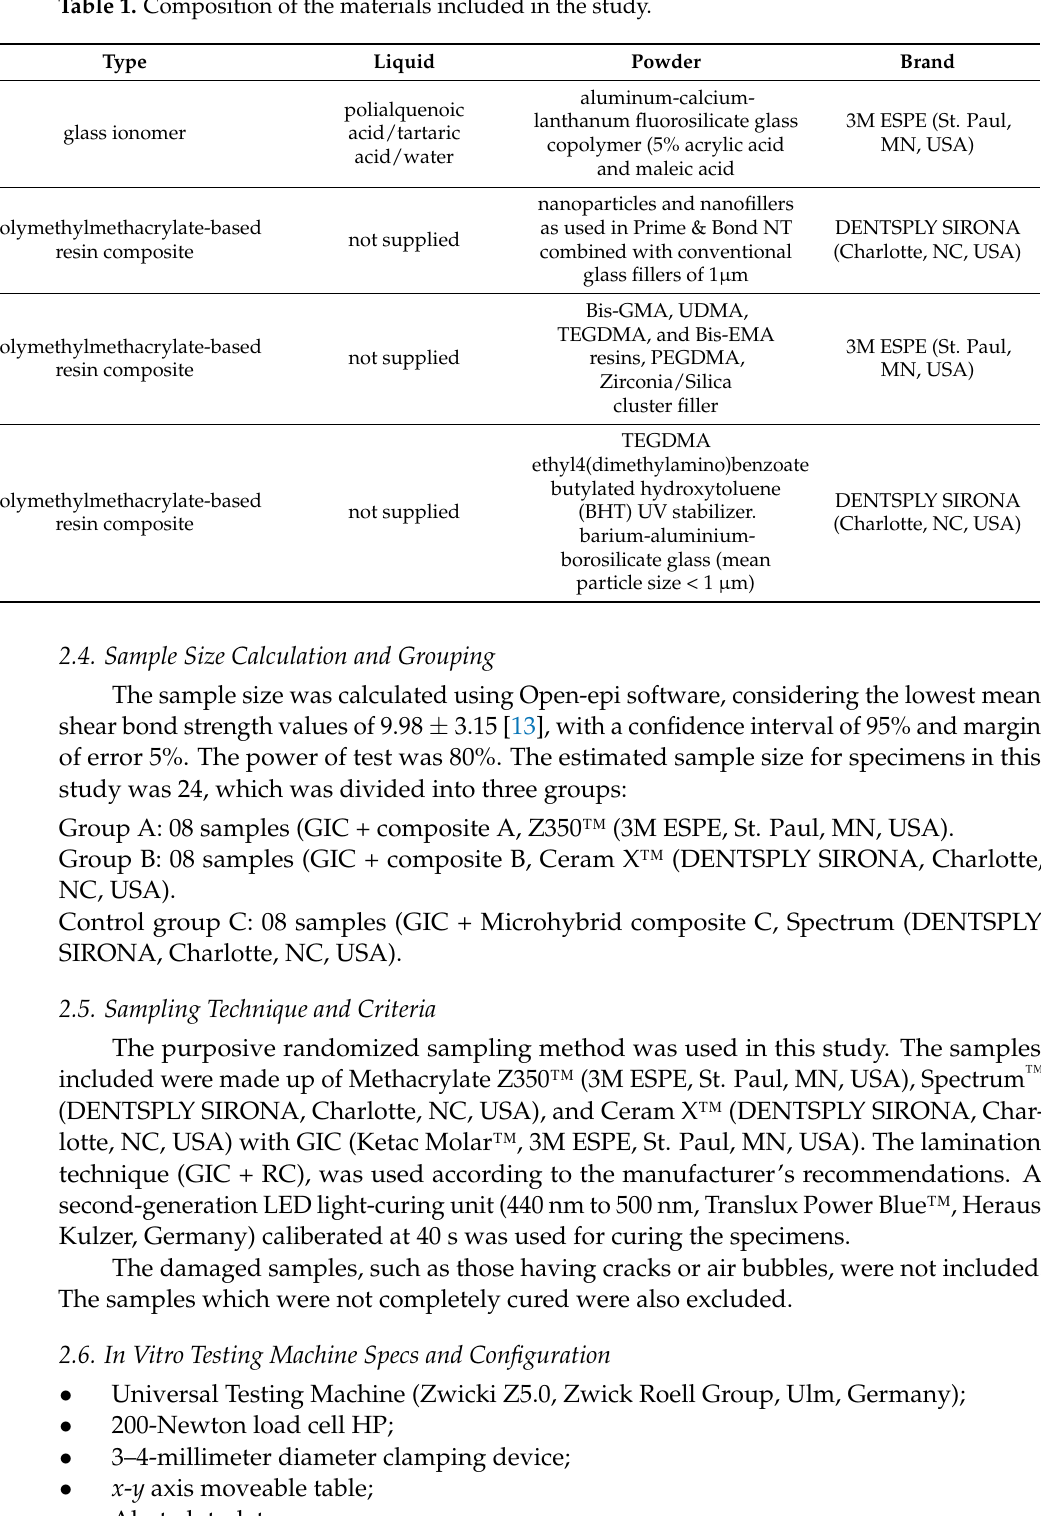
Table 1. Composition of the materials included in the